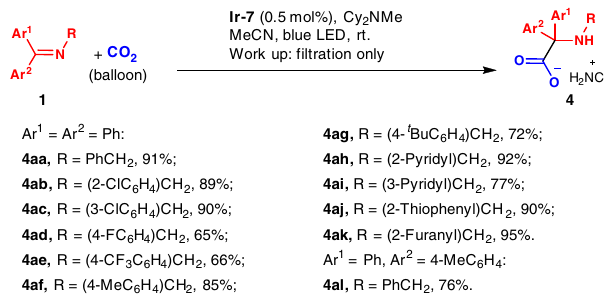
Fig. 2 Visible light-mediated catalytic hydrocarboxylation of ketimines using CO 2 . Reactions were conducted with 1 (0.2 mmol), CO 2 (balloon), Ir-7 (0.5 mol%), and Cy 2 NMe (0.4 mmol) in 2 mL MeCN at RT under 20 W blue LED irradiation. 2 mol% of Ir-7 was used in the case of 3x. Isolated yields